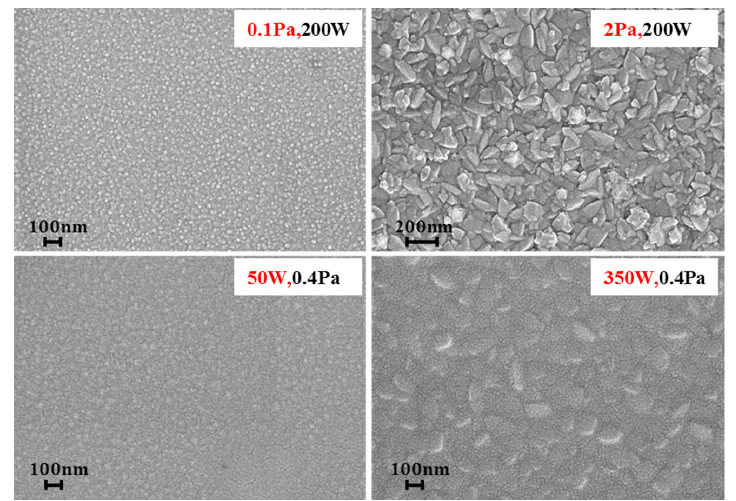
Figure 6. SEM characterization of the surface morphology of the films under different sputtering parameters (with the same multiples of 50 K). Table 2. Sputtering experimental parameters used for the first time.